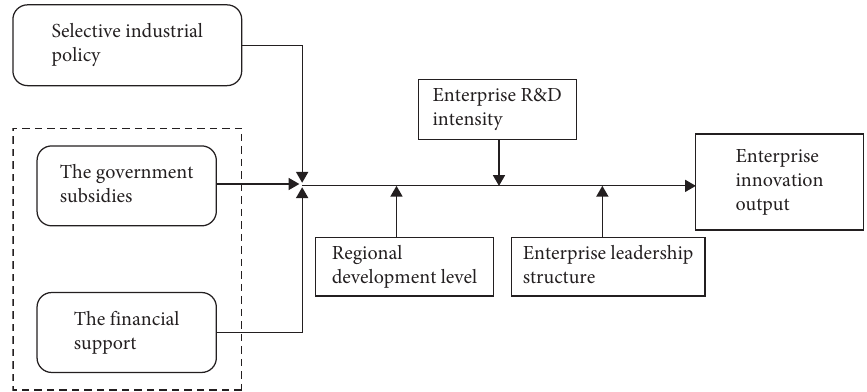
Figure 1: The path of industrial policy affecting enterprise